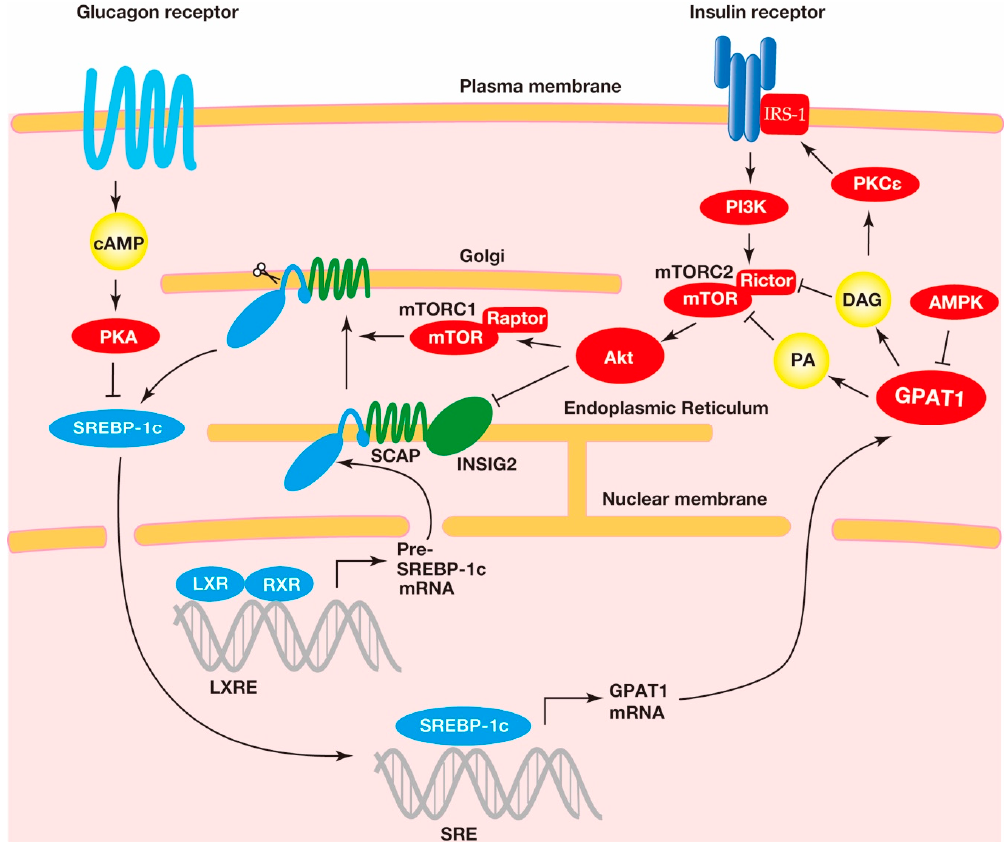
Figure 3. The regulation of the expression and cleavage of sterol regulatory element-binding protein-1c (SREBP-1c) and the transcriptional activation of the acyl-CoA:glycerol- sn -3-phosphate acyltransferase1 (GPAT1) gene. A heterodimer consisting of the liver X receptor (LXR) and retinoid X receptor (RXR) binds to the SREBP-1c precursor gene promotor region at the LXR response element for transcriptional activation. The SREBP-1c precursor resides at the endoplasmic reticulum membrane with the SREBP cleavage-activating protein (SCAP) and insulin-induced gene (INSIG) proteins. The complex, consisting of the SCAP and the SREBP-1c precursor, translocates to the Golgi, where the SREBP-1c precursor undergoes proteolytic cleavage. This translocation is involved in the mechanistic target of rapamycin complex 1 (mTORC1)-mediated indirect activation of protein kinase B (Akt), a downstream kinase of insulin signaling. In addition, Akt decreases INSIG2 mRNA and translocates the